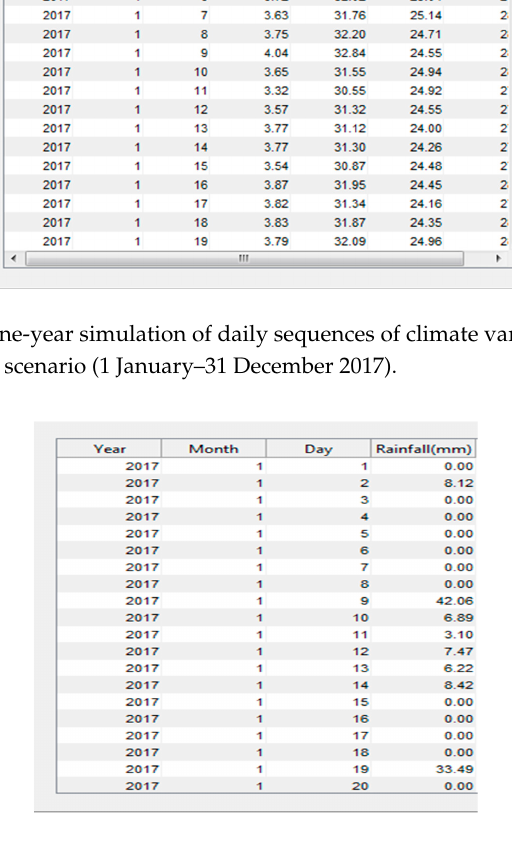
Figure 8. Example of a one-year simulation of daily rainfall sequences using the CCSM4 model under the RCP4.5 scenario (1 January–31 December 2017.